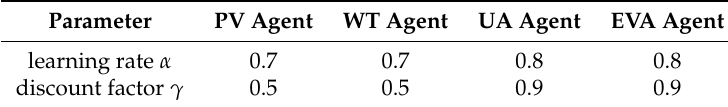
Table 2. Parameters of RL